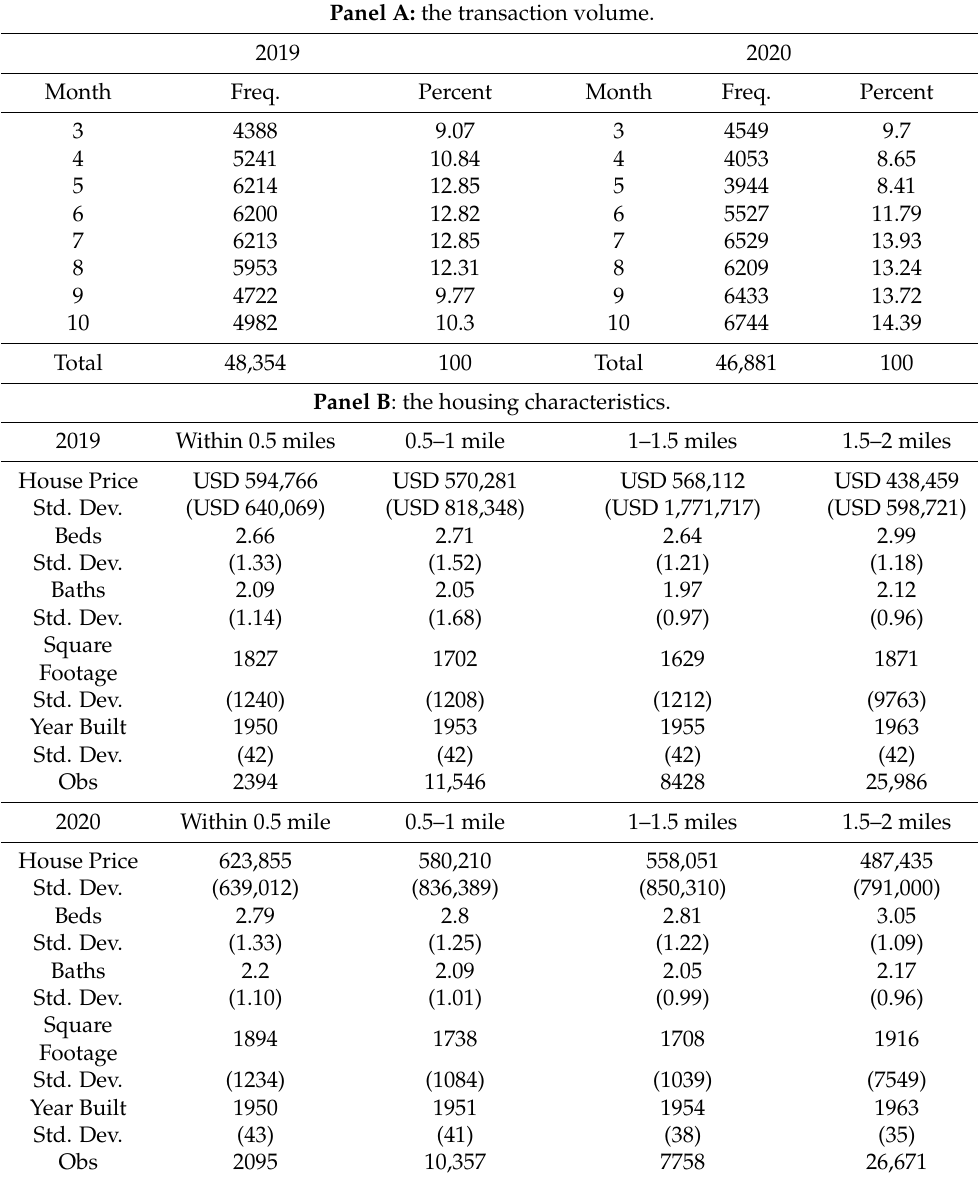
Table 1. Summary characteristics of housing